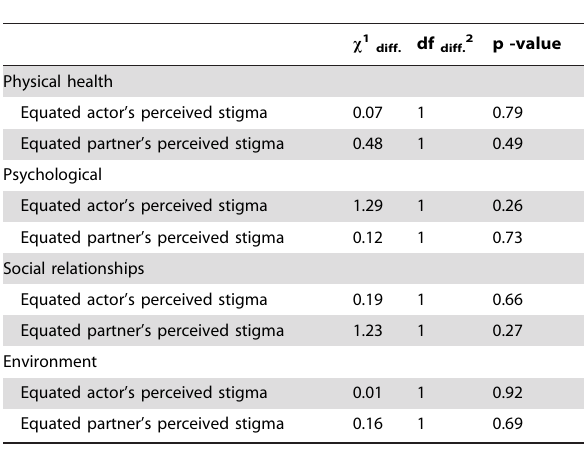
Table 4. Equality constraint tests regarding model